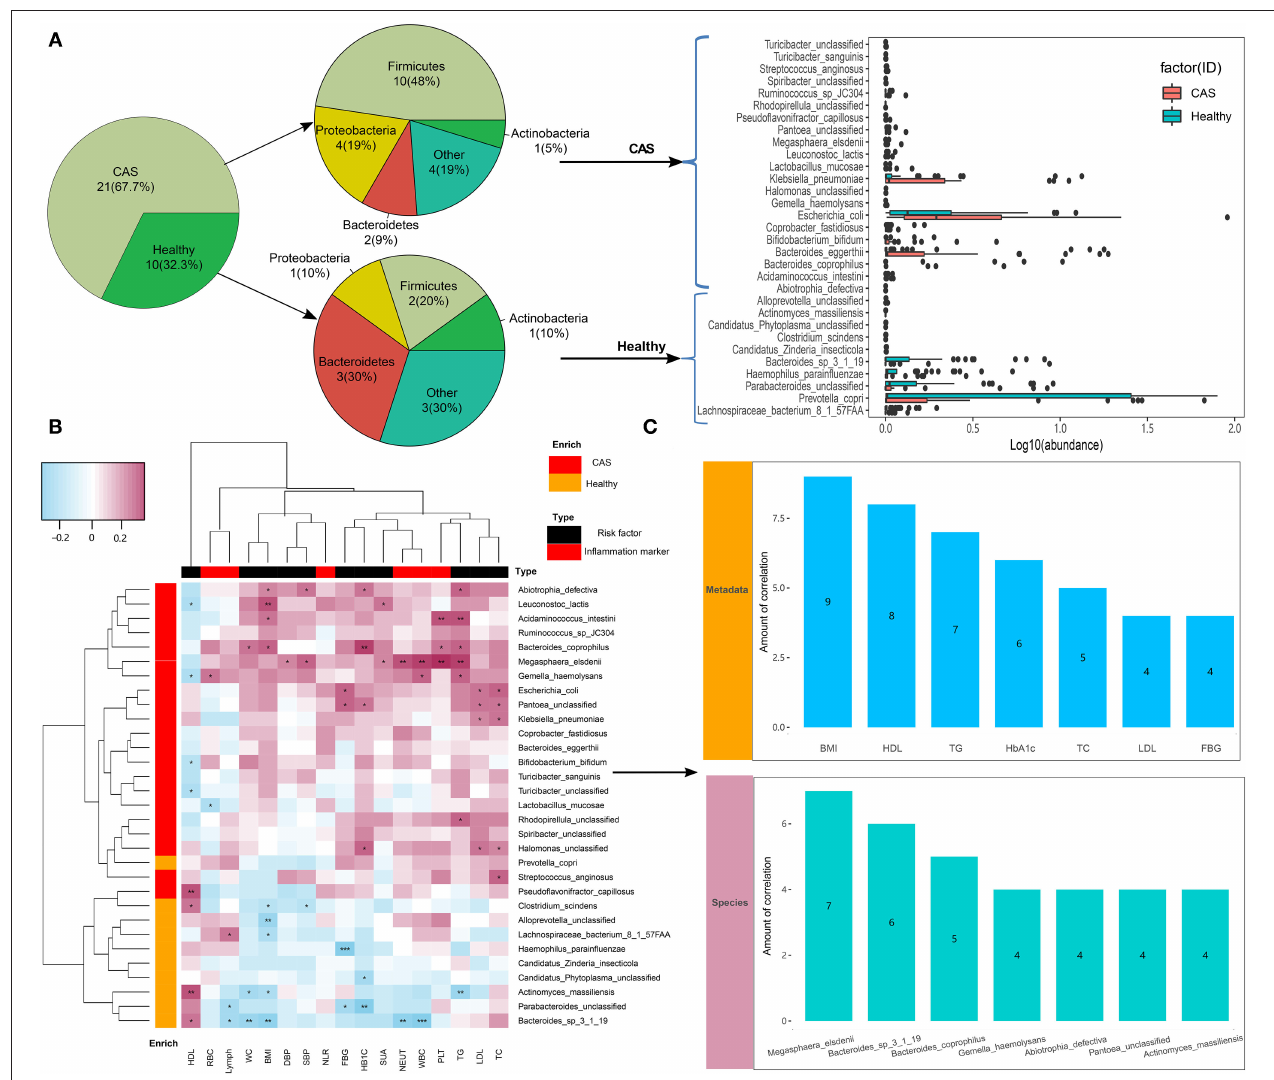
FIGURE 3 | Microbiome differences between the groups and the associations with clinical characteristics. (A) Species with differences in abundance between the carotid arteriosclerosis (CAS) and healthy control groups. (B) Correlation matrix for species and clinical parameters. Pink cells denote positive correlations, whereas blue cells depict negative correlations. *, **, and *** denote p < 0.05, p < 0.01, and p < 0.001, respectively. (C) The number of significant correlations for the seven risk factors and seven species with the most frequent